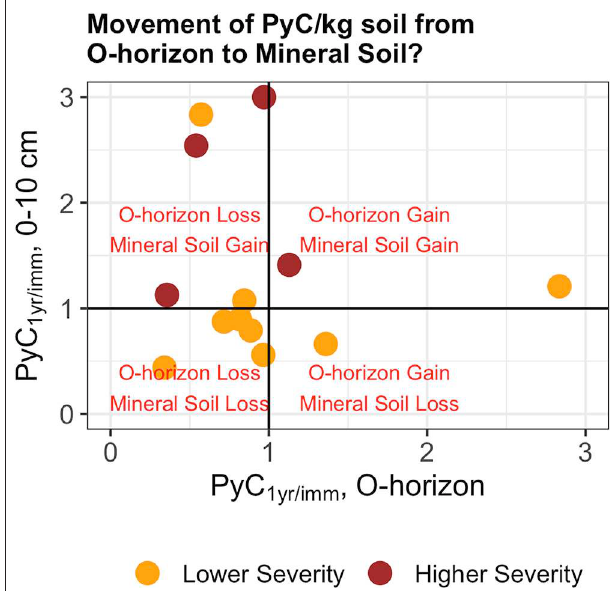
FIGURE 6 | The soil mass normalized ratio of PyC concentration in a given depth at the 1-year post-fire time point to the concentration in the same depth at the immediate post-fire time point (PyC 1yr / imm ) is a measure of whether PyC concentration is increasing or decreasing over time; a ratio < 1 indicates that the PyC concentration at that depth has decreased over the year, while a ratio > 1 suggests the PyC concentration